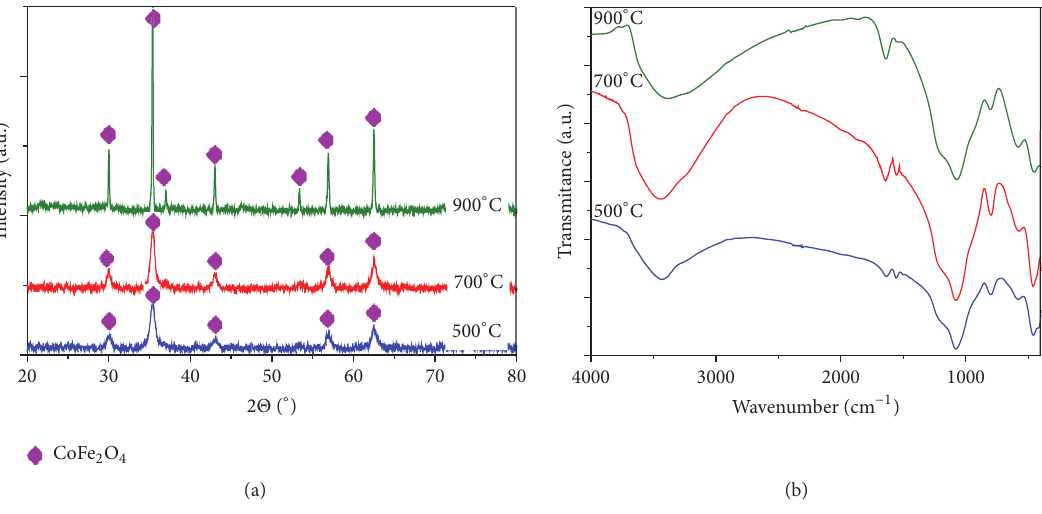
Figure 4: XRD patterns (a) and FT-IR spectra (b) of the gels obtained using 1,4-BD, annealed at 500, 700, and 900 ∘ C.